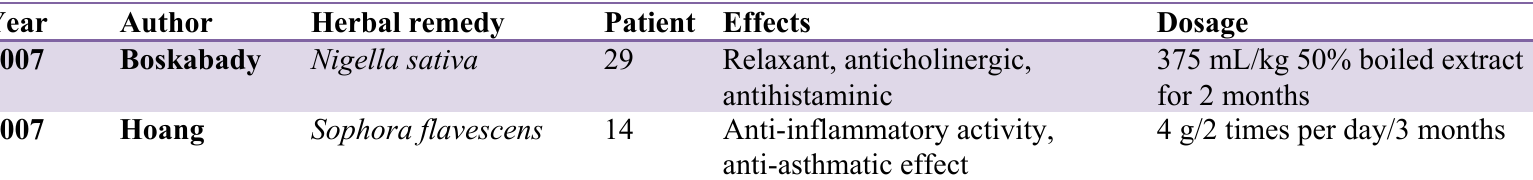
Table 2. Herbal remedies in the treatment of